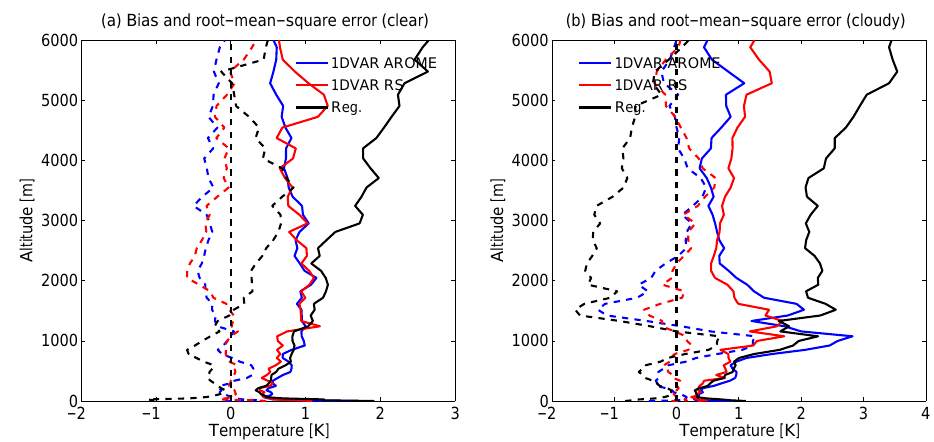
Figure 11. Vertical profiles of bias (dashed lines) and root-mean-square errors (solid line) of 1DVAR retrievals using either AROME 1h forecast (blue) or previously launched radiosonde (red) as background. 1DVAR retrievals are performed with bias correction and using all elevation angles (90 to 5.4 ◦ ). Comparison with linear regressions (black line). Left panel shows results on 56 clear-sky temperature profiles while right panels shows results on 25 cloudy-sky temperature profiles.